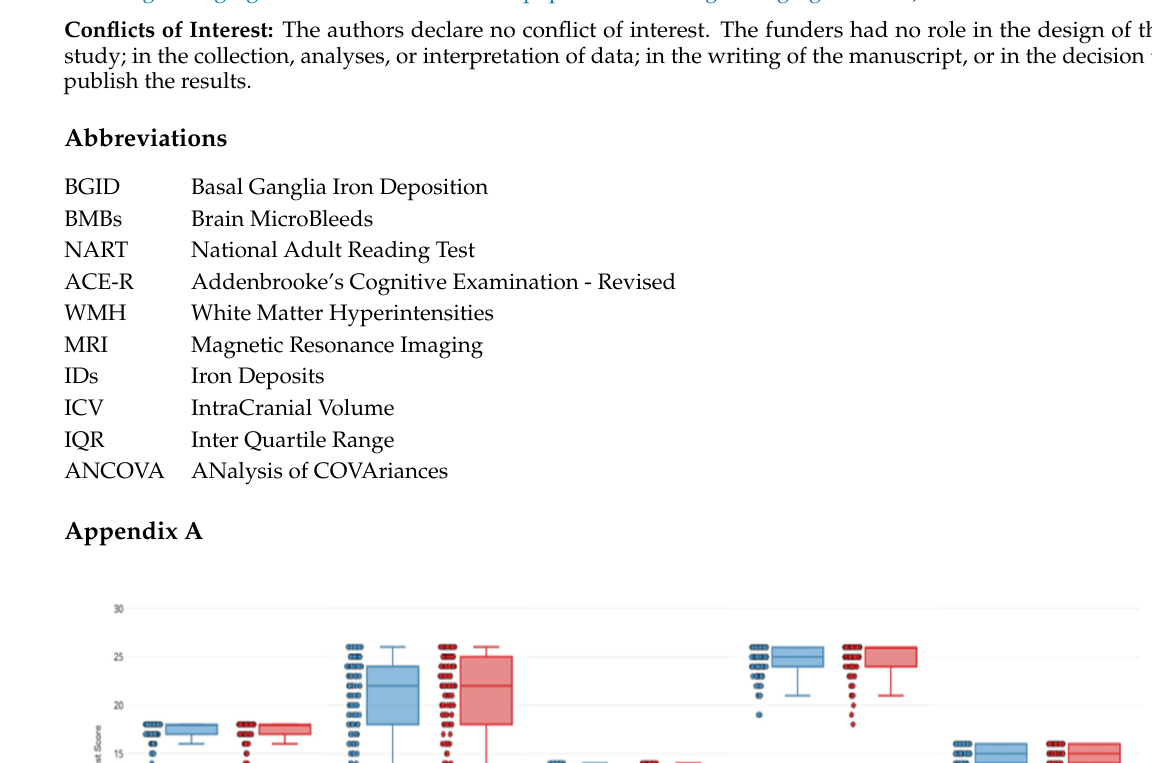
Table A2. Demographics of patients who had cognitive testing vs. those recruited but who did not undergo cognitive testing.